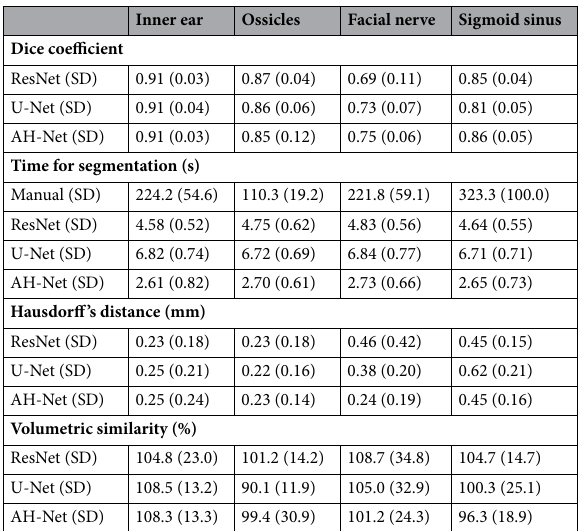
Table 3. Results of objective validation of the automated segmentation of the testing dataset using the prediction pipeline (n = 25). SD Standard deviation.